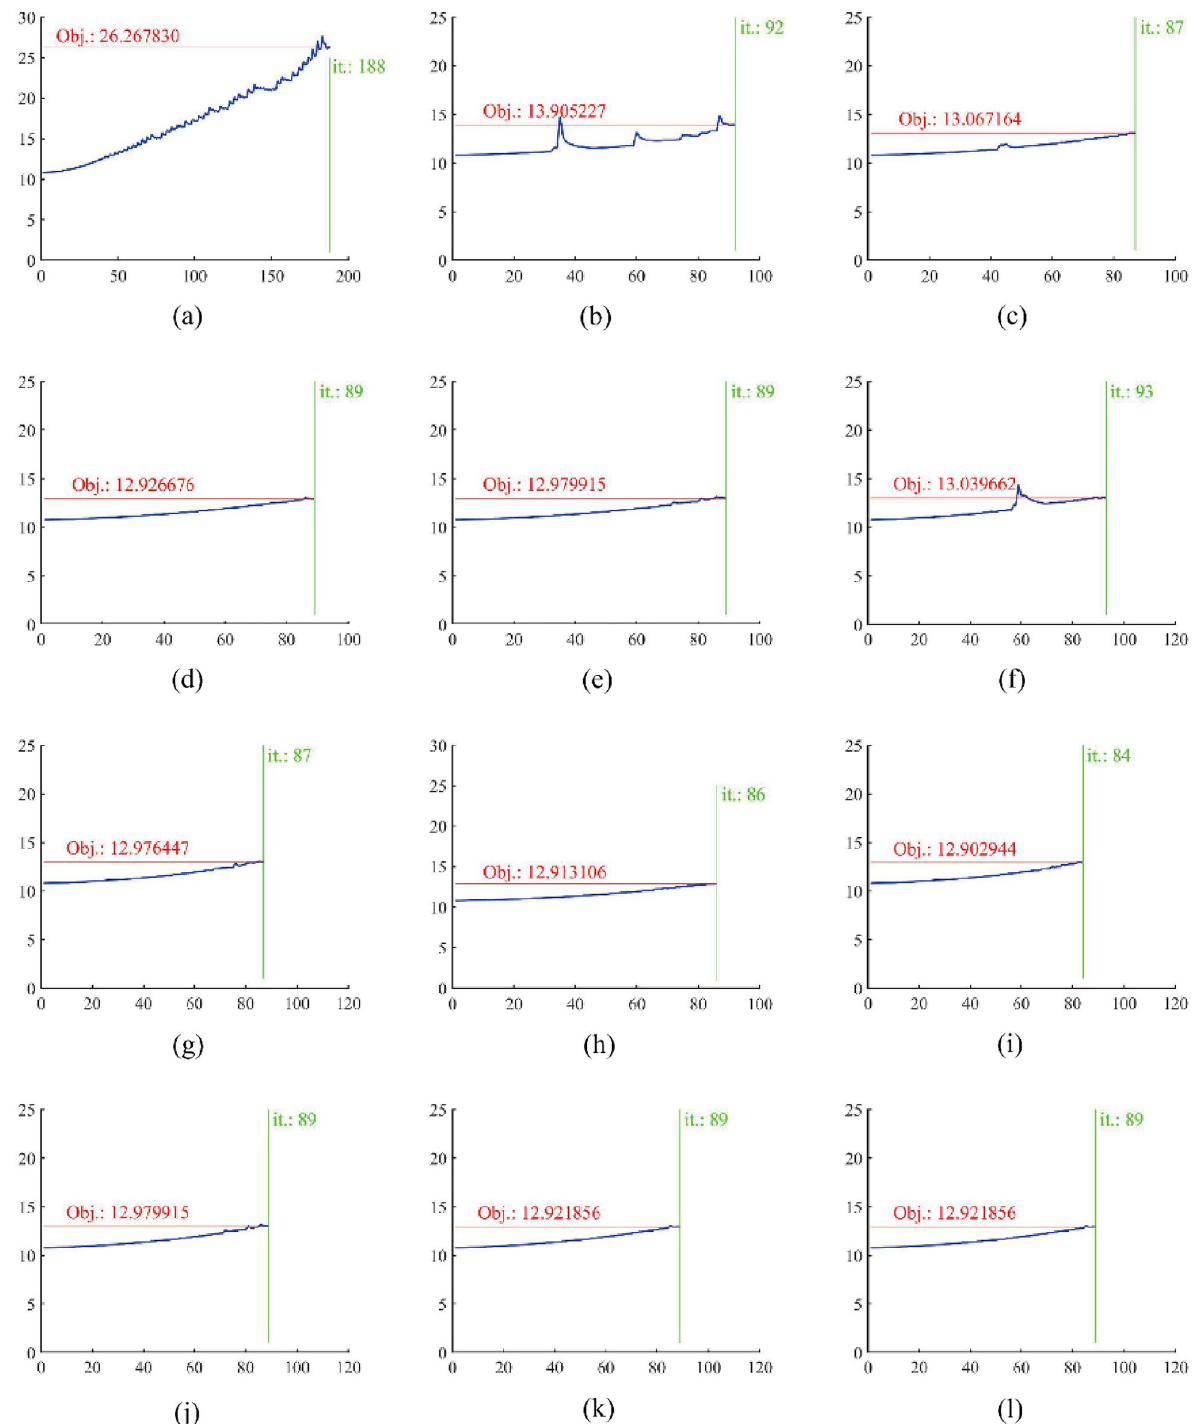
Figure 10. Change in the objective function value of the structure during the optimization process for the example in Fig. 8. The line marked “Obj.” gives the final value of the objective function. The line marked “it.” gives the maximum iteration